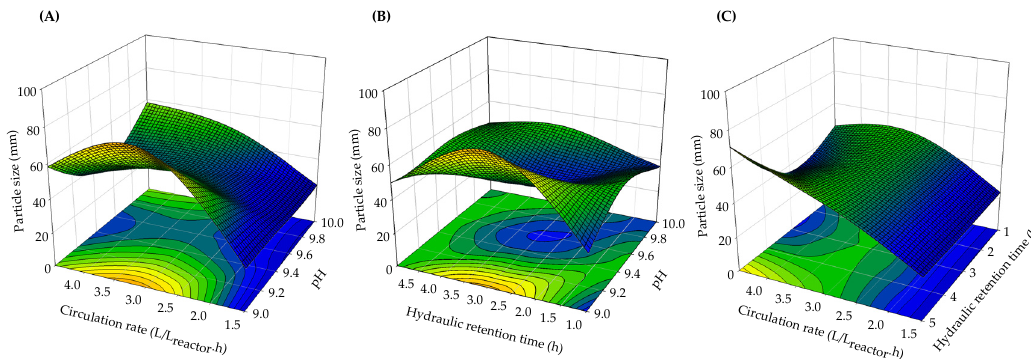
Figure 4. 3D response surface plots showing the effects on struvite particle size of: ( A ) pH × circulation rate, ( B ) pH × hydraulic retention time, and ( C ) circulation rate × hydraulic retention time. According to Equation (6), CR ( x 2 ), CR( x 2 ) × HRT( x 3 ), pH ( x 1 2 ), and CR ( x 2 2 ) closely influenced